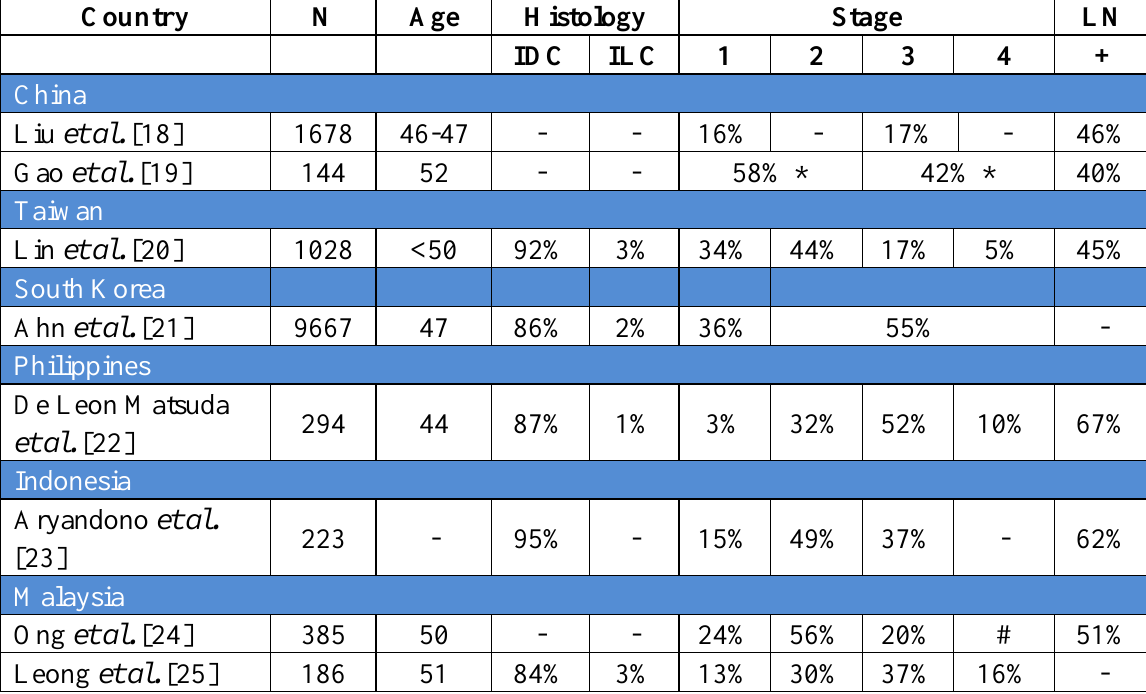
Table 2. South East